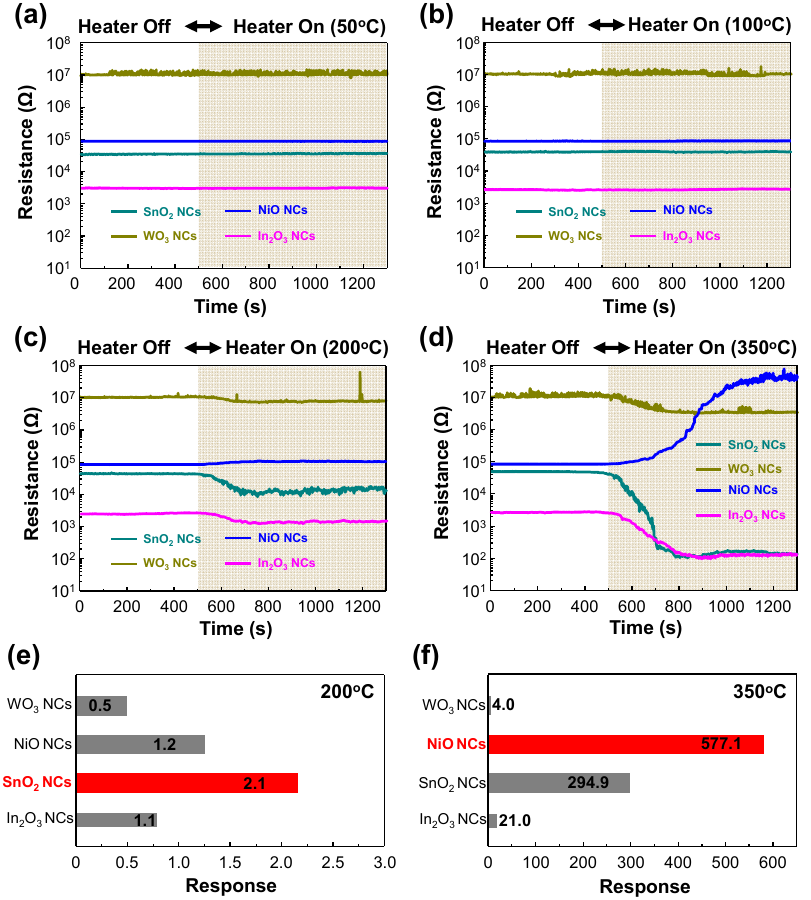
Figure 6. Real-time transient response of all samples (SnO 2 , NiO, WO 3 and In 2 O 3 ) at different hot-plate temperatures: ( a ) 50 °C, ( b ) 100 °C, ( c ) 200 °C and ( d ) 350 °C. Responses of all samples at hot-plate temperatures of ( e ) 200 °C and ( f ) 350 °C.